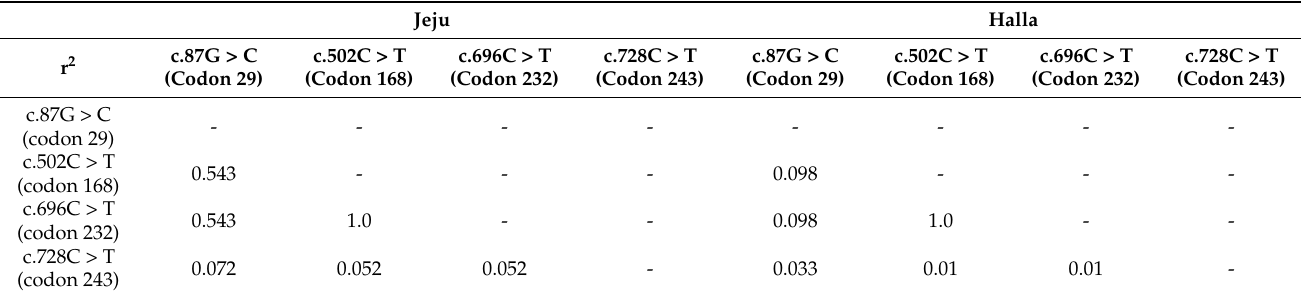
Table 3. Linkage disequilibrium (LD) among four SNPs of the shadow of prion protein gene ( SPRN ) gene in outbred horses, Jeju and halla